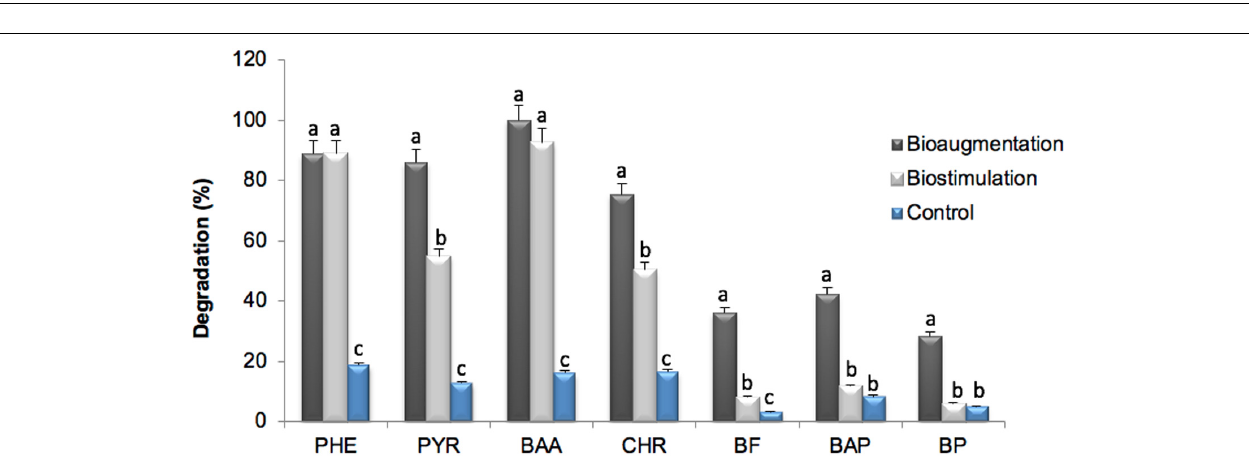
FIGURE 2 | Alkane fractions in control soil and treatments after 120 days of incubation in microcosms experiments. Same lowercase letters indicate, between microcosms and vs. control soil, respectively, lack of statistically significant difference ( P < 0.05).